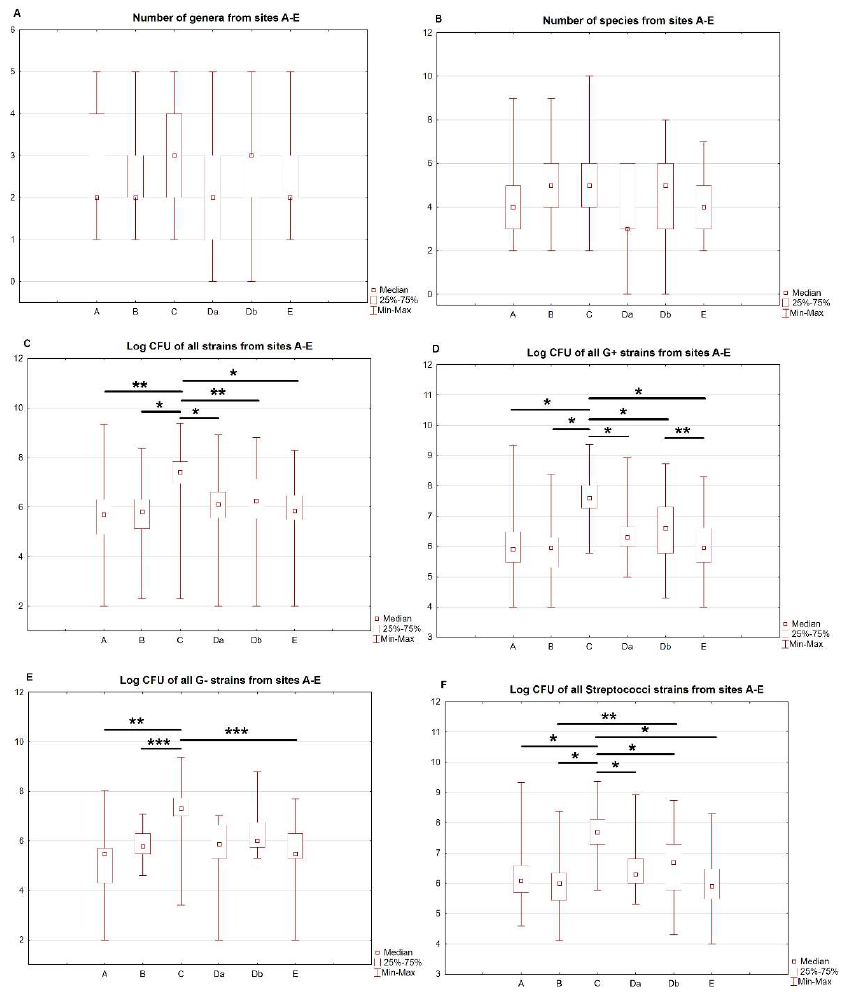
Figure 2. Log CFU of all bacterial and fungal strains from all sites A–E. * extreme values, ◦ outliers.